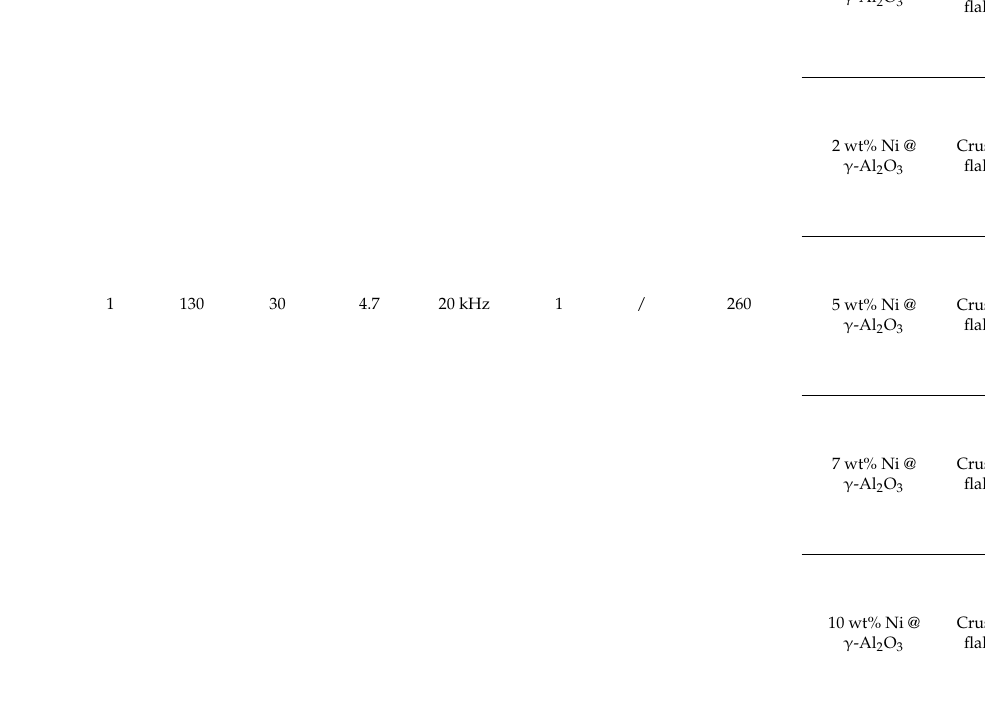
Table 1. Summary of a selection of literature for CO 2 splitting in a non-packed and a packed DBD reactor.